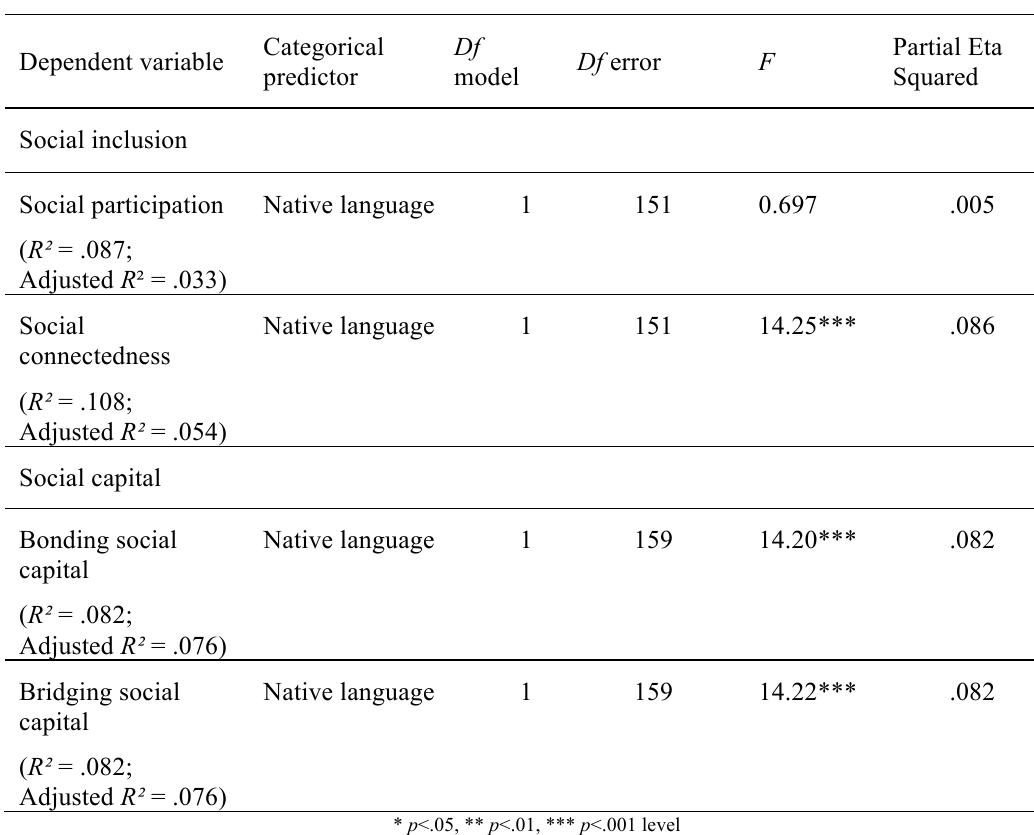
Table 6 : Results of univariate ANOVA’s among online adult learners. Case 2: Differences among blended adult learners with regard to social inclusion and social